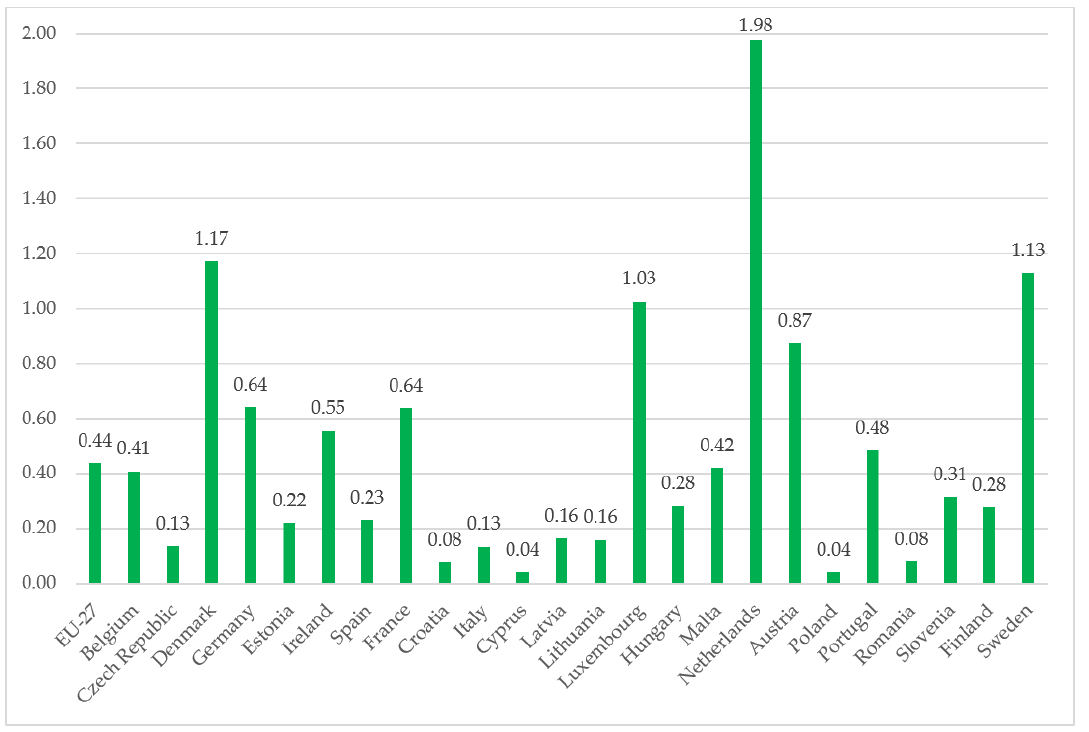
Figure 4. The share of passenger electrical cars in EU countries in 2020, %. Note: the data for Bulgaria, Greece and Slovakia are not available. Source: [74].